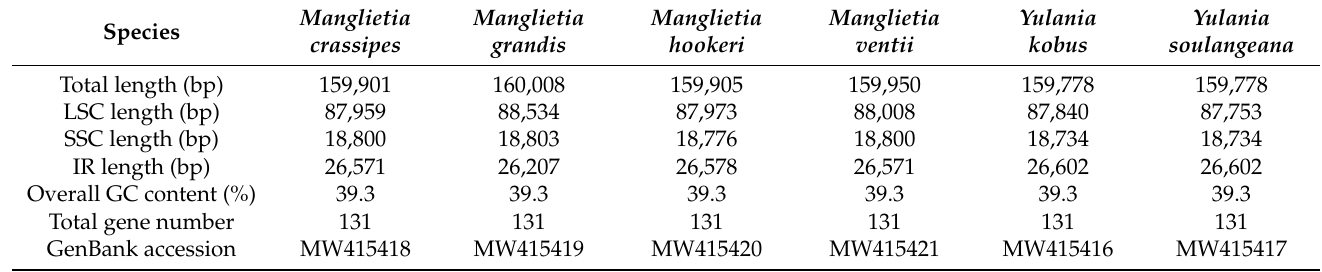
Table 2. Summary of chloroplast genome characteristics of six Magnoliaceae chloroplast